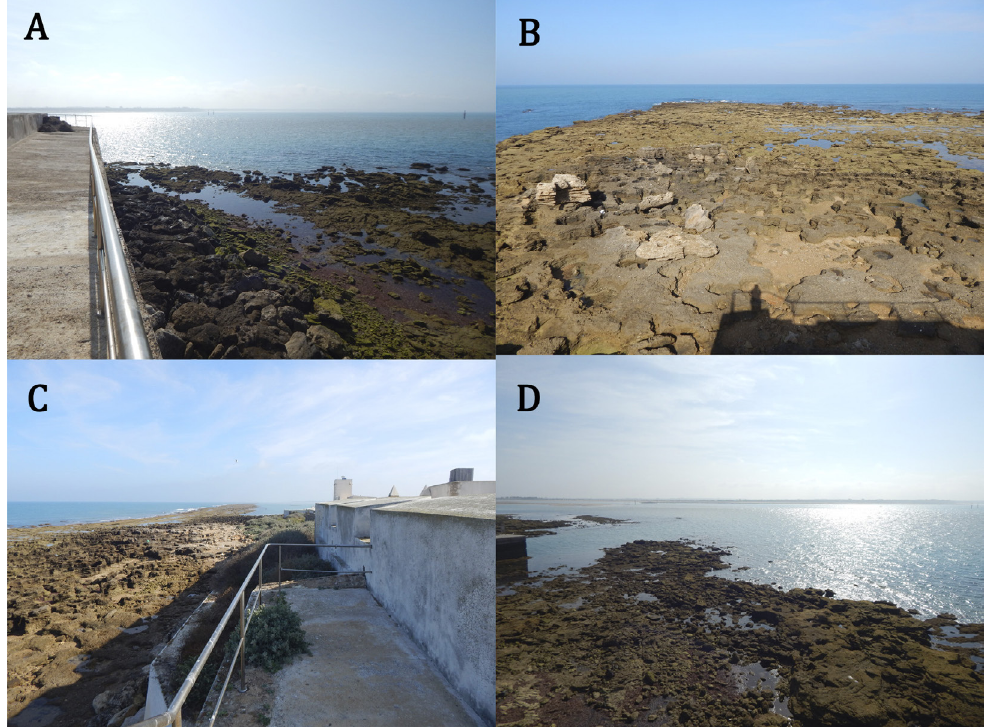
Figure 8. Experimental visualisation from Sancti Petri Castle-point 1 (CSP-South Side). A. Towards the S. B. Towards the open sea (W.). C. Towards the N. D. Towards the mainland (E.). ©Authors.